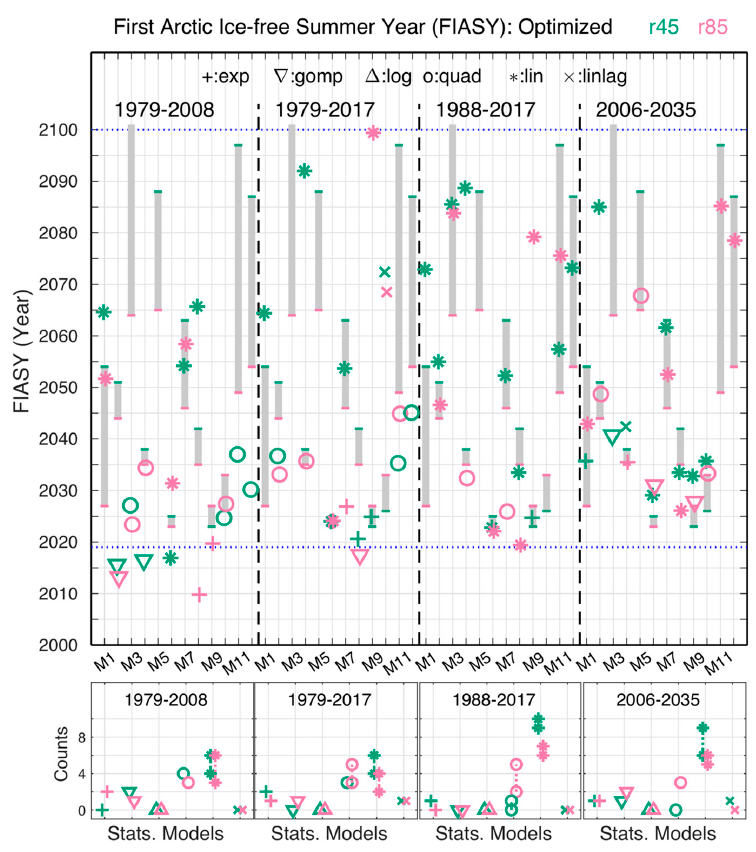
Figure 9. Top panel: the predicted FIASY by the optimal curve-fitting model for each of the 12 climate models for the four considered periods. Green / pink colors are for the r45 / r85 scenarios, respectively. The grey vertical bars in each period represent the spread of the FIASY values from the r45 / r85 projections (see Section 3.4). Bottom panel: the count of how many times each of the six statistical curve-fitting models was selected as the optimal model for each of the four periods when using FIASY values lower than 2100. FIASY values later than 2100 are represented in the diagram by adding the value to that of the same statistical model. The shapes denote the types of the curve-fitting models, as described by the top panel legend.